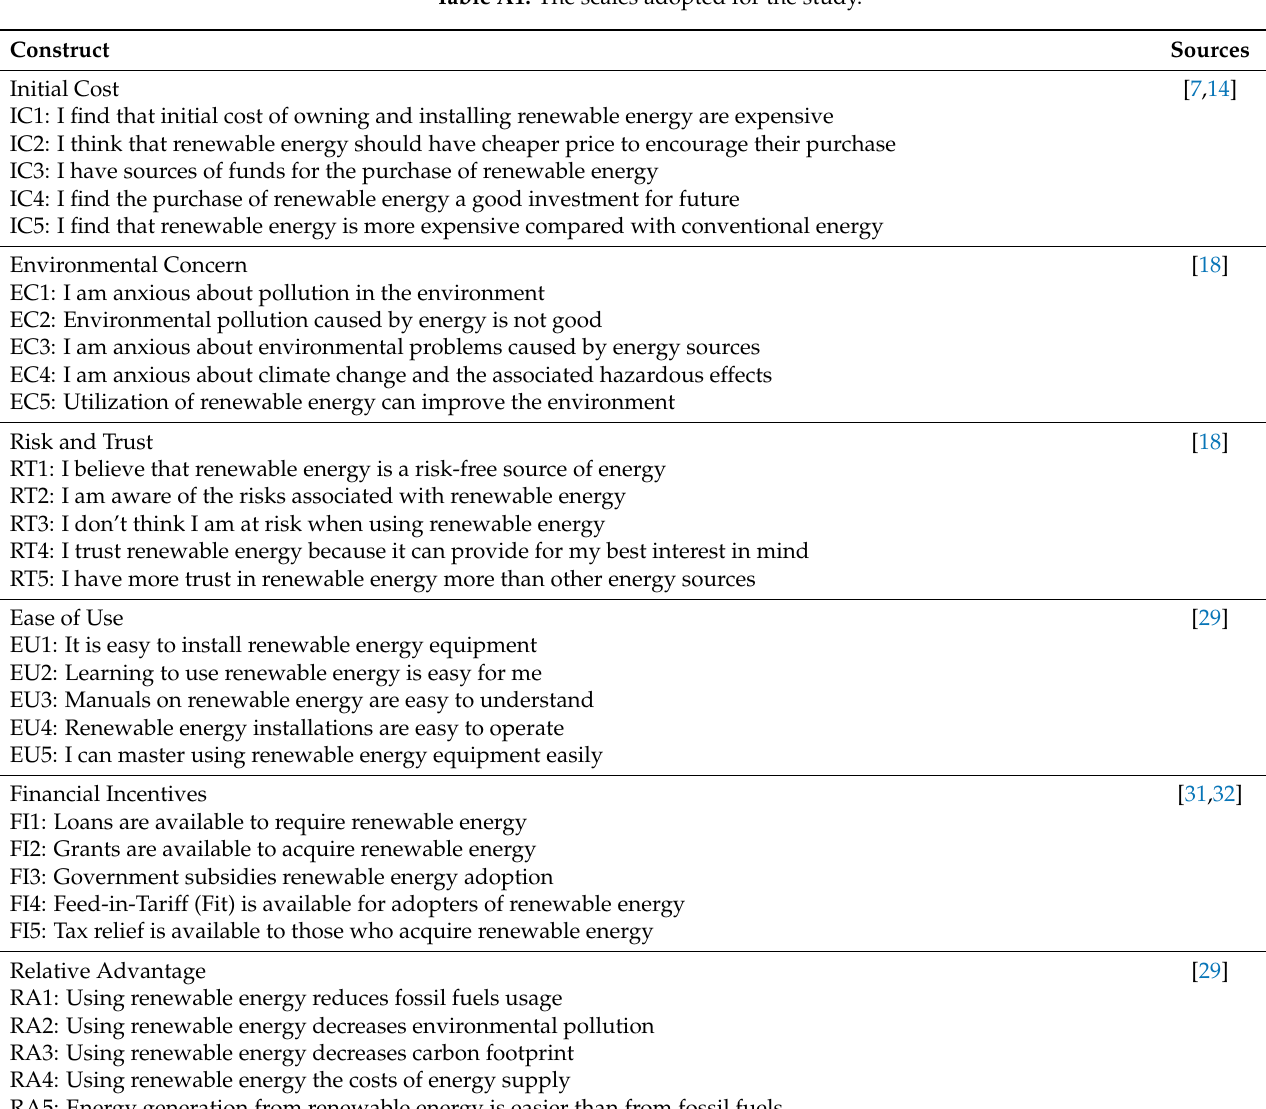
Table A1. The scales adopted for the